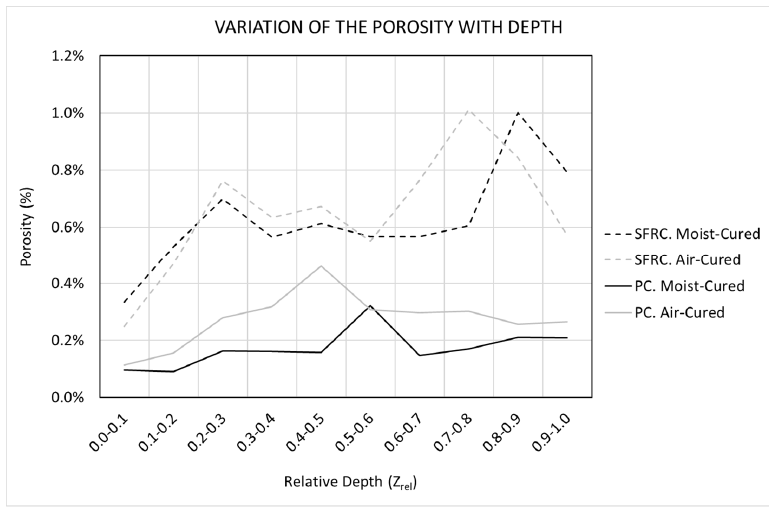
Figure 6. Variation of the porosity along the depth.